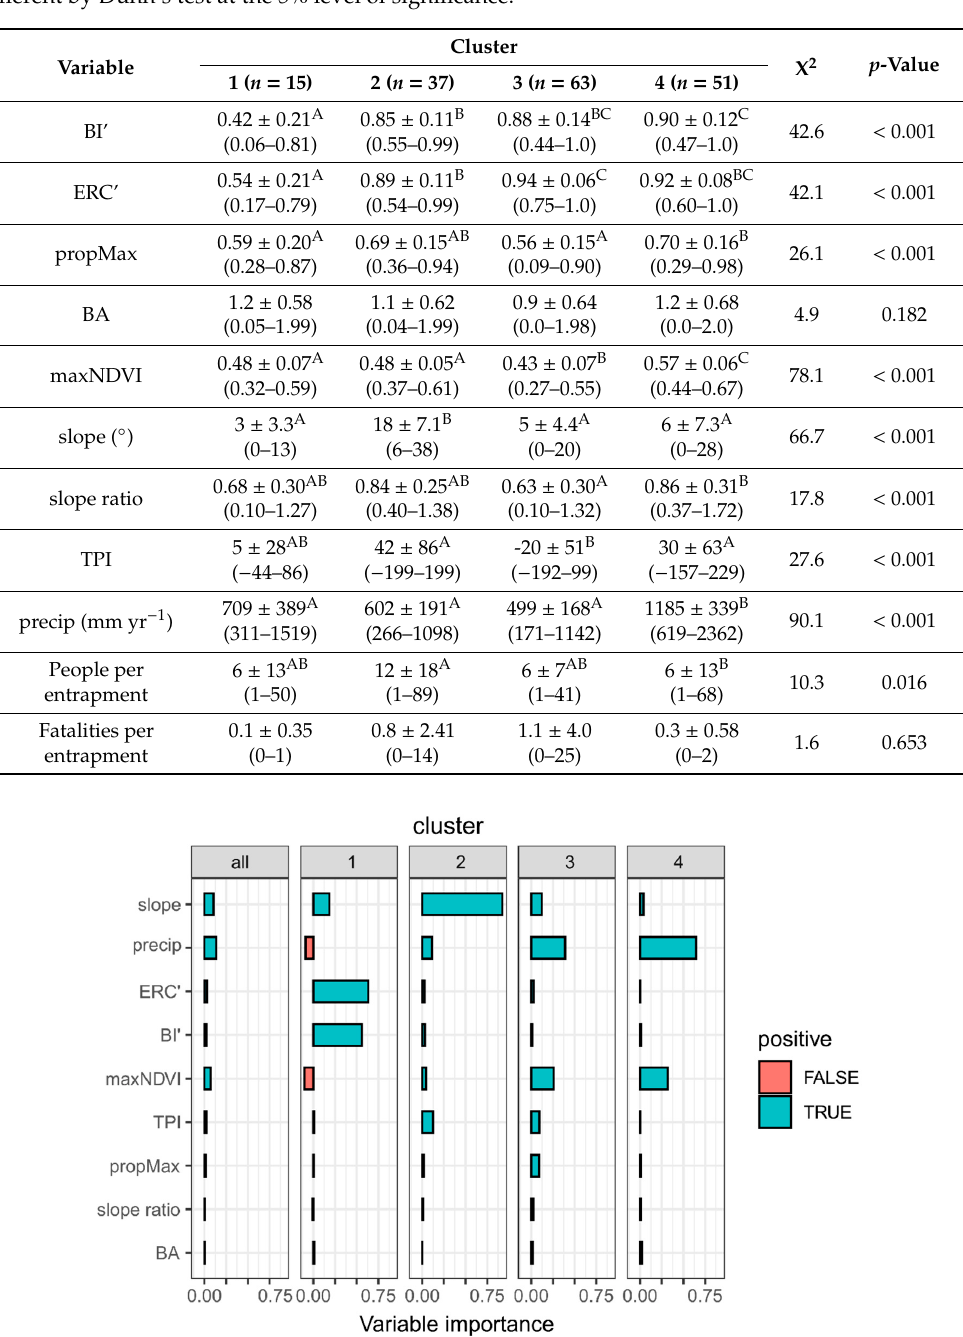
Figure 4. Relative importance of the various environmental variables used to classify firefighter entrapments by cluster using Random Forests [49]. A negative value indicates that the variable had a detrimental impact on the classification. See Table 2 for variable